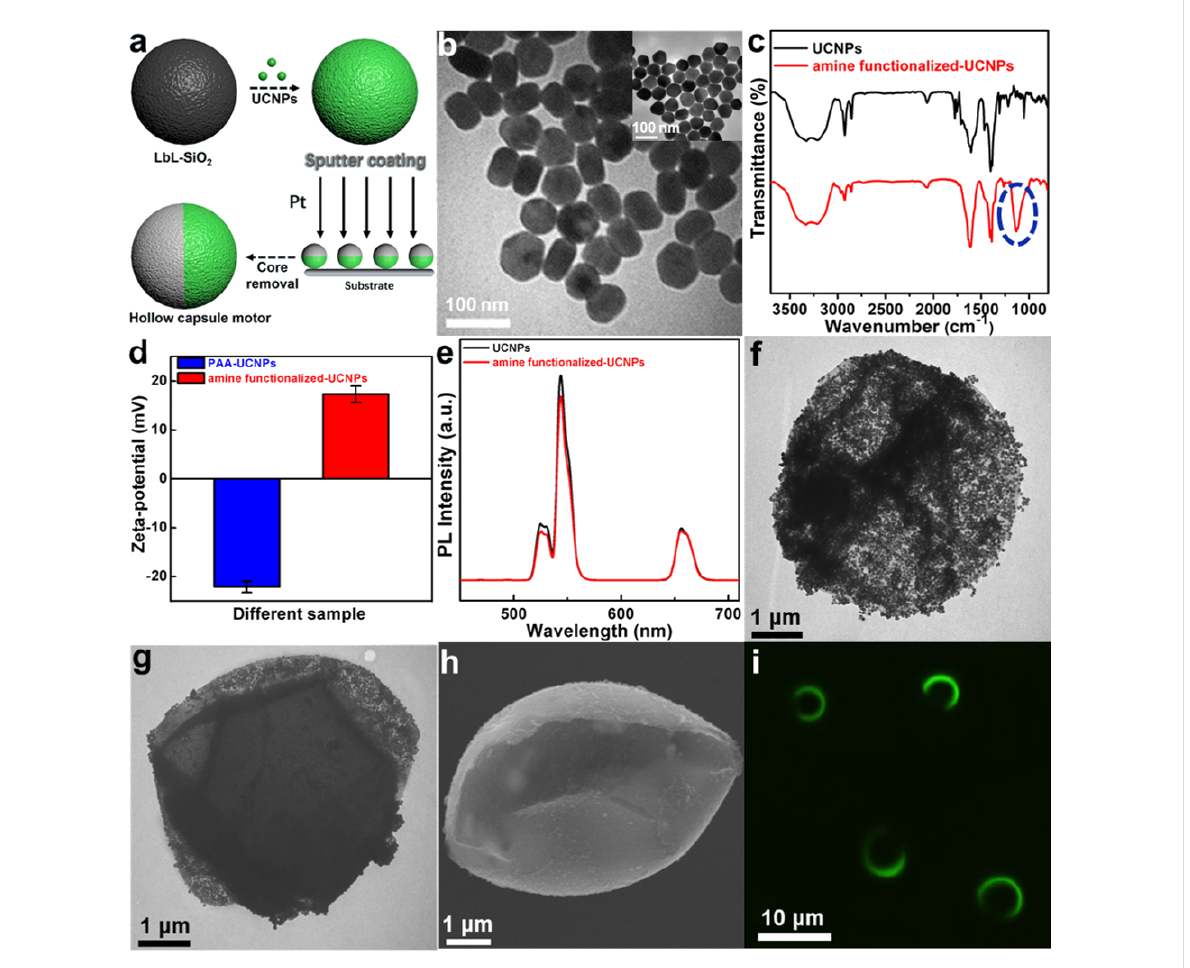
Figure 1: (a) Schematic representation of the fabrication process of Janus UCNP-modified polyelectrolyte capsule motors. (b) TEM images, (c) FTIR spectra, (d) zeta potential and (e) fluorescence emission spectrum of UNCPs with different surface functional groups. TEM images of UCNP-modified capsule (f) and Janus UCNP capsule motor (g). (h) SEM image of the Janus UCNP capsule motor. (i) Fluorescence microscope image of the Janus UCNP capsule motors.